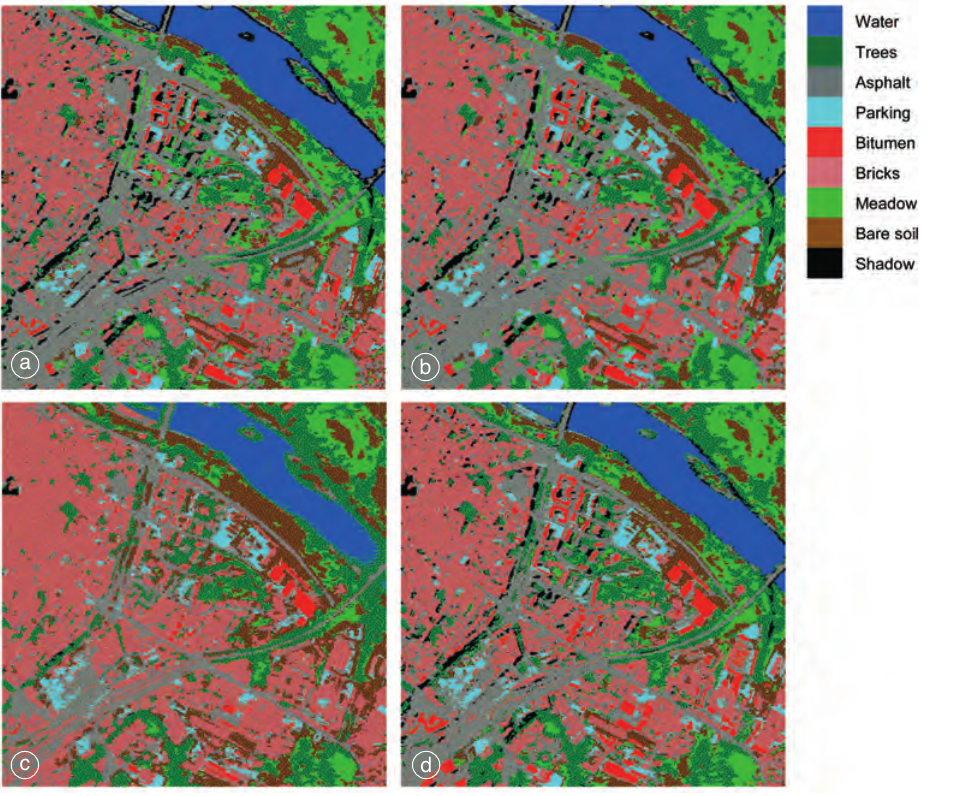
Fig. 3a-d. Classification maps for a) the spectral ARTMAP and b) spatial ARTMAP classifier applied to the data after a DAFE analysis; classification maps for c) the ECHO and d) Maximum Likelihood classifier applied to the data after a DAFE analysis.